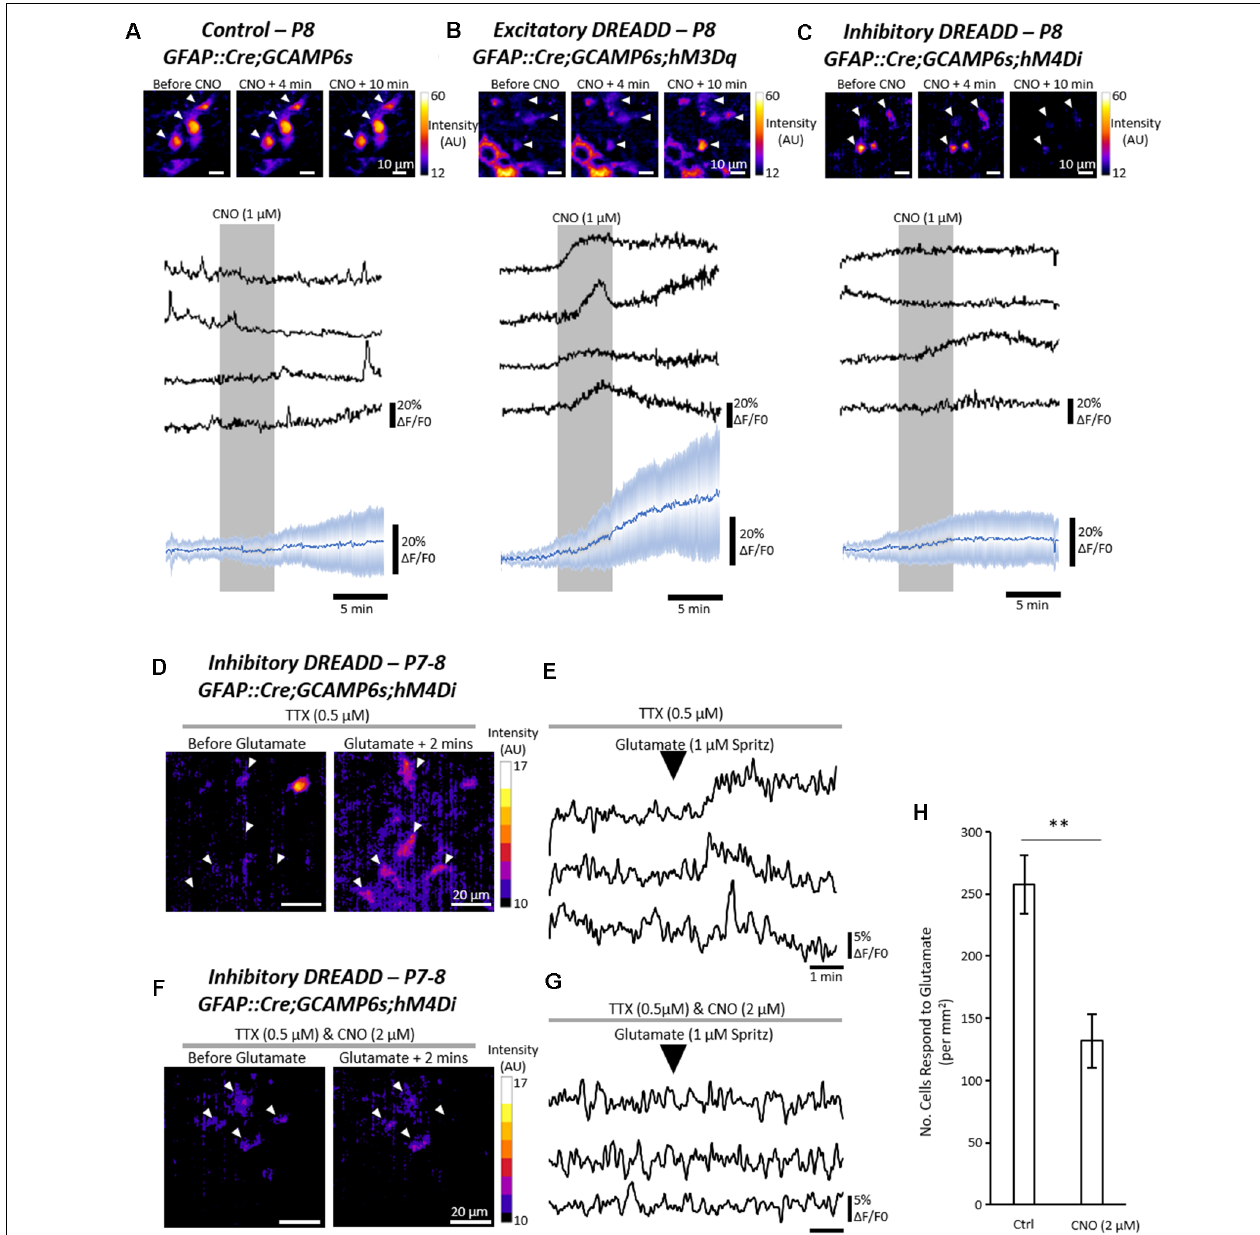
FIGURE 3 | Pharmacogenetic techniques can manipulate astrocytic Ca 2+ activity in the mammalian spinal cord. (A) Ca 2+ imaging of GFAP::cre;GCAMP6s astrocytes in response to Clozapine-N-Oxide (CNO). Example (top), and averaged (bottom) traces of Ca 2+ imaging from astrocytes during applications of CNO (19 cells for averaged trace). (B) Ca 2+ imaging of GFAP::cre;GCAMP6s;hM3Dq astrocytes in response to CNO. Example (top), and averaged (bottom) traces of Ca 2+ imaging from astrocytes during applications of CNO (25 cells for averaged trace). (C) Ca 2+ imaging of GFAP::cre;GCAMP6s;hM4Di astrocytes in response to CNO. Example (top), and averaged (bottom) traces of Ca 2+ imaging from astrocytes during applications of CNO (30 cells for averaged trace). (D) Ca 2+ responses in GFAP::cre;GCAMP6s;hM4Di astrocytes in response to glutamate, perfused in TTX to prevent neuronal-mediated responses. (E) Example traces of Ca 2+ responses in GFAP::cre;GCAMP6s;hM4Di astrocytes in response to glutamate. (F) Ca 2+ responses in GFAP::cre;GCAMP6s;hM4Di astrocytes in response to glutamate, perfused in both TTX and CNO to inhibit astrocyte activity. (G) Example traces of Ca 2+ responses in GFAP::cre;GCAMP6s;hM4Di astrocytes showing no response to glutamate due to pharmacogenetic inhibition with CNO. (H) Bar chart displaying the number of astrocytes responding to glutamate in GFAP::cre;GCAMP6s;hM4Di spinal cord slices under control conditions and when perfused with CNO to inhibit astrocytes. ∗∗ p < 0.01.